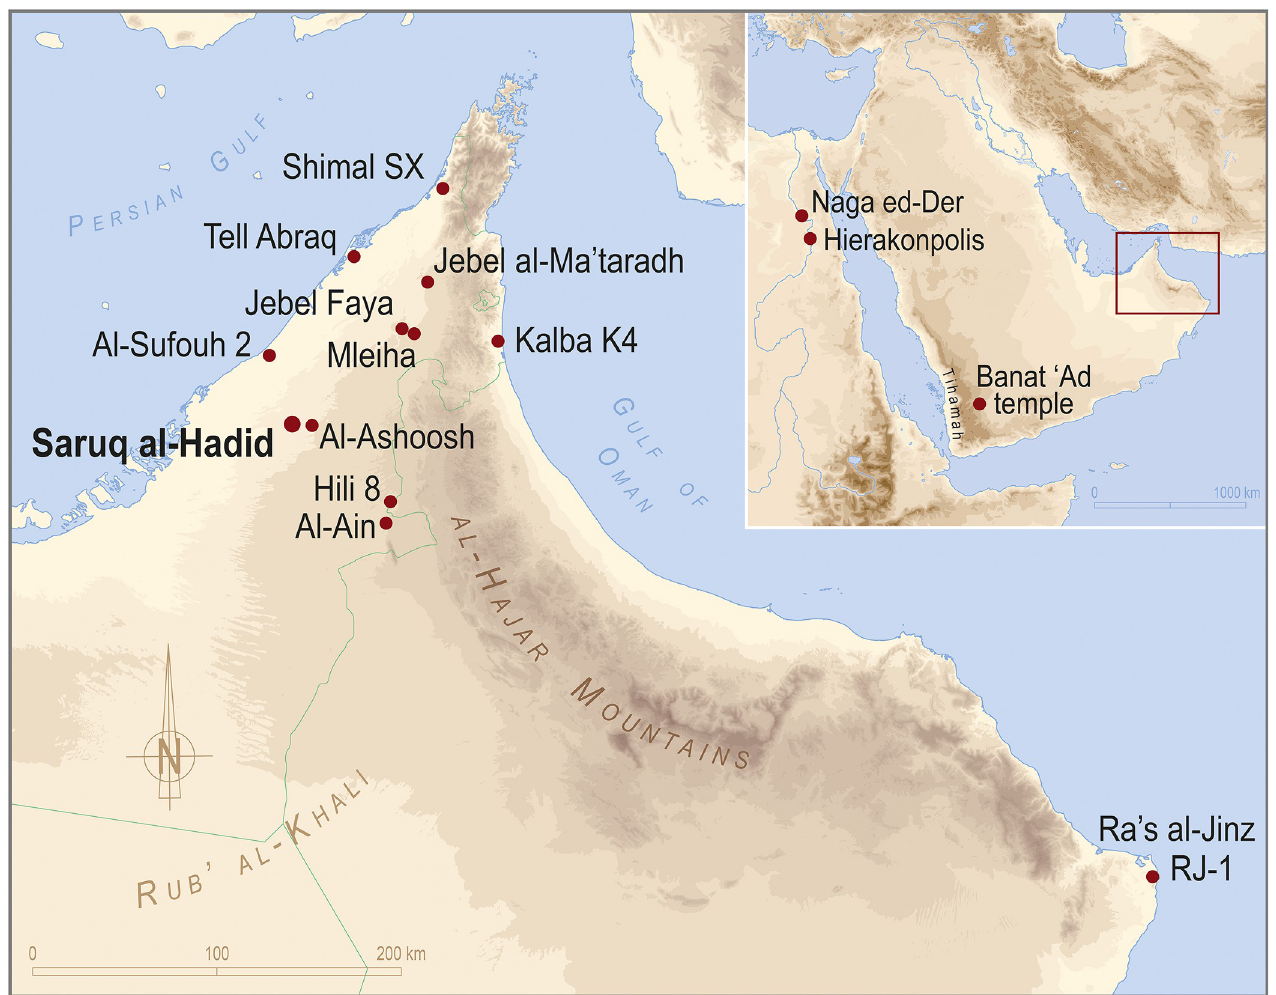
Fig 1. Southeastern Arabia showing locations discussed in the text. Figure by He´l è ne